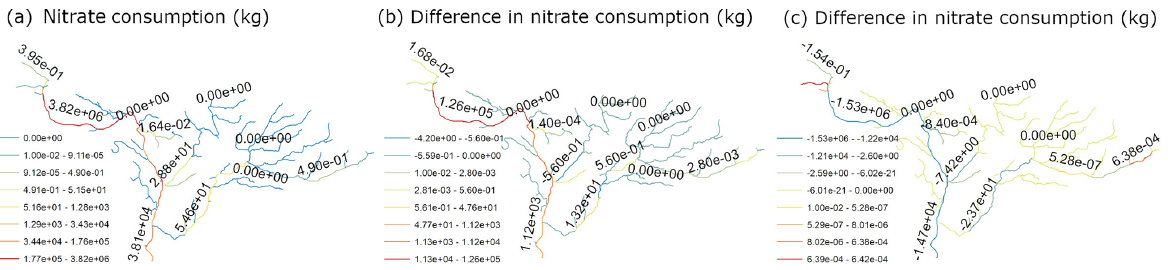
Figure 7. Total nitrate consumption through HZ denitrification at the end of simulation using a single storage zone in both vertical and lateral HZs (a) . Change in nitrate consumption with 10 sub-storage zones in both vertical and lateral HZs compared to the simulation with a single storage zone using uniform exchange flux (b) and nonuniform exchange flux (c)